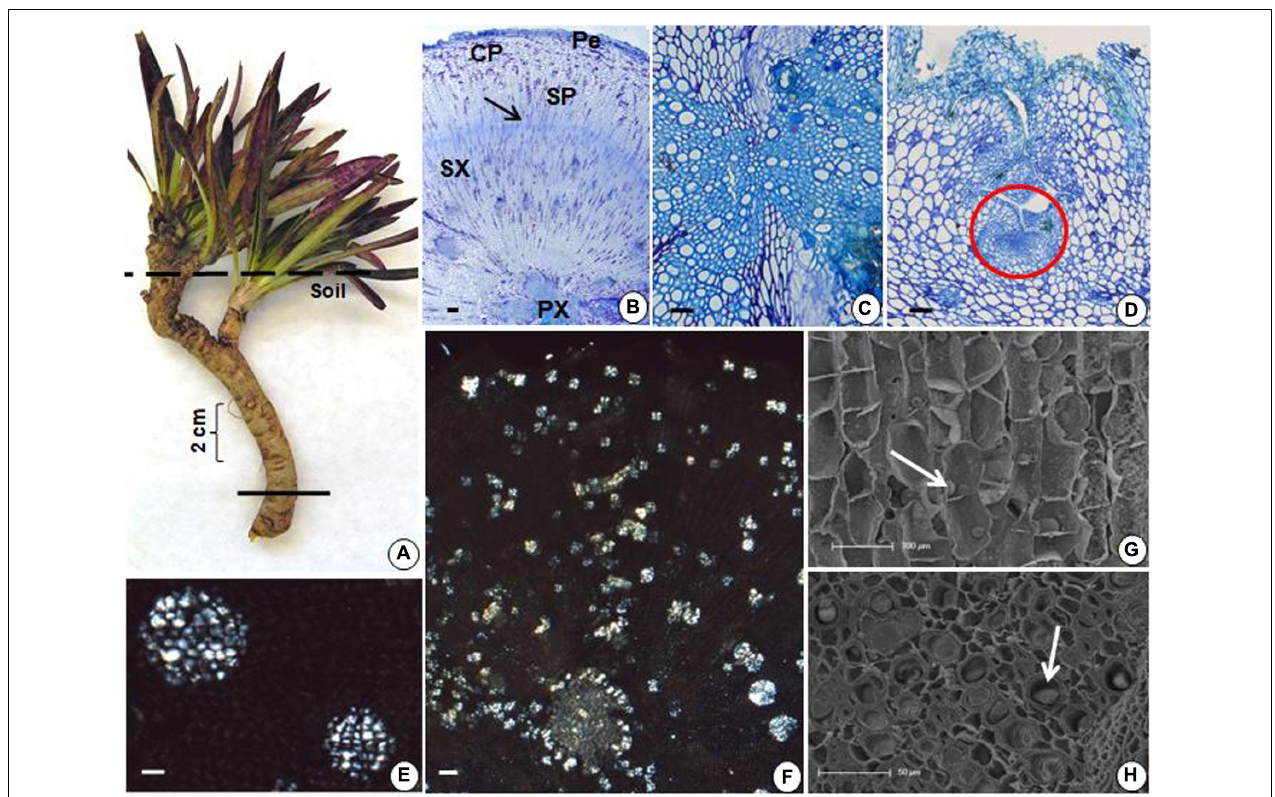
FIGURE 5 | (A) General view of G. marginata ; continuous line indicates the sectioned region. (B–H) Transverse sections of tuberous root. (B) General view showing periderm (Pe), cortical parenchyma (CP), secondary phloem (SP), secondary xylem (SX), cambium (arrow), and primary xylem (PX). (C) Detail of the central region of the tuberous root. (D) Presence of bud (circle). (E,F) Fructan spherocrystals visualized under polarized light, forming at times clusters (E) in the parenchyma cells of the cortex, in the secondary phloem and xylem (F) . (G,H) Scanning electron micrographs with fructan spherocrystals (arrows) in the parenchymatic cortex (G) and inside the vessel elements (H) . Scale bars: 200 µ m (B,F) , 100 µ m (D,G) , and 50 µ m (C,E,H)